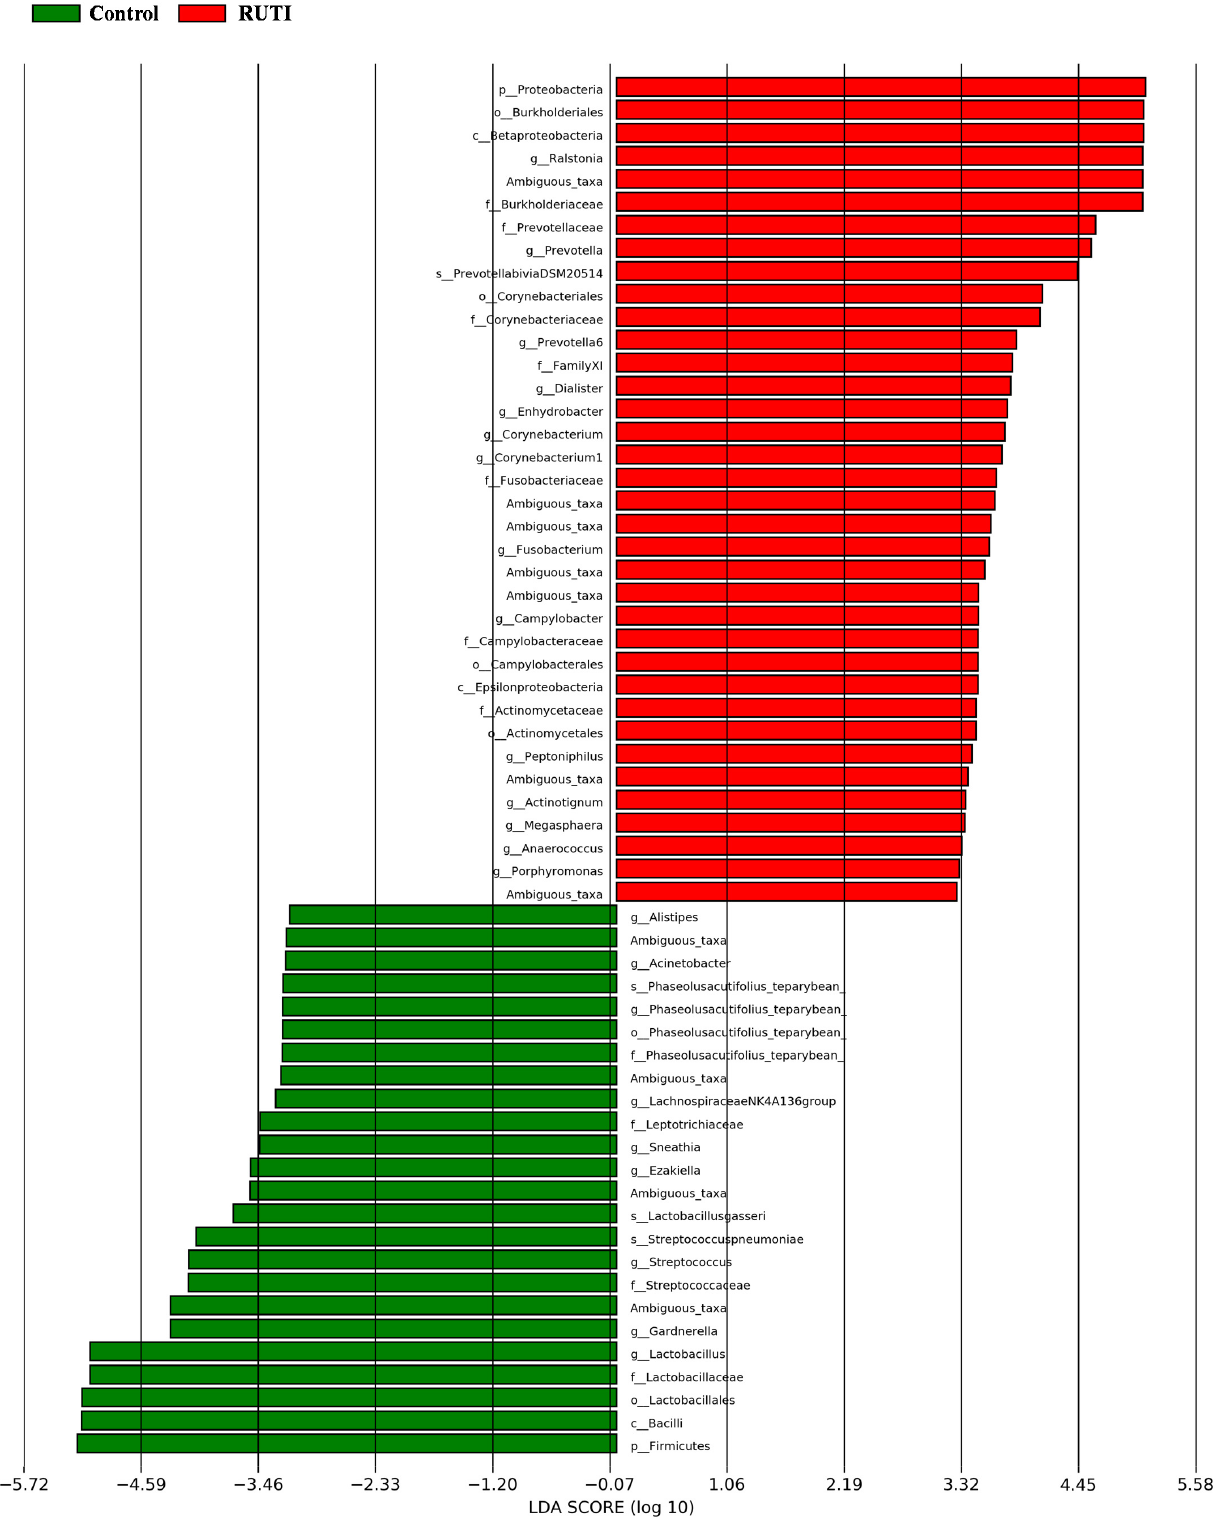
Frontiers in Microbiology |